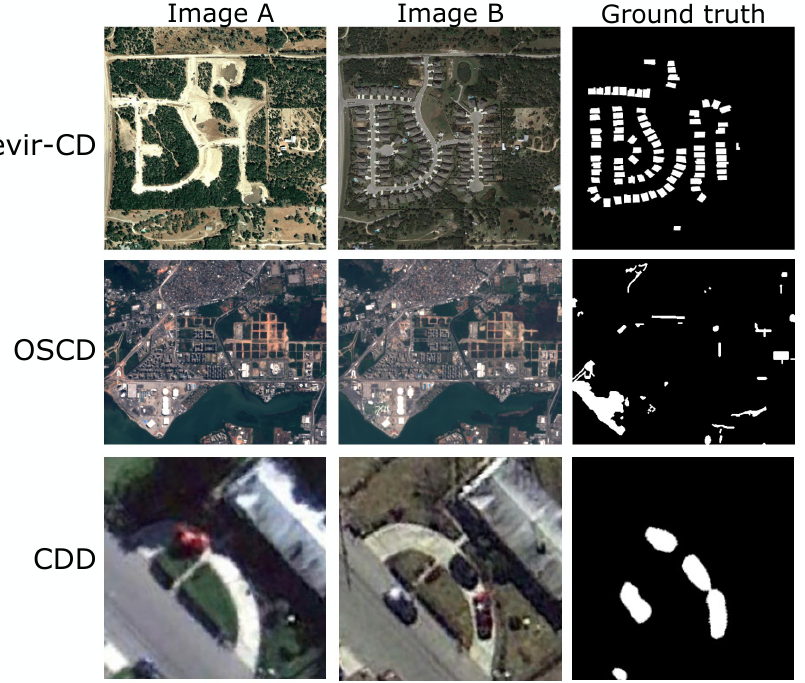
Figure 1. Examples of images and ground truth from various datasets, namely, Levir-CD [43] (with a focus on building changes), OSCD [39] and CDD [40] (various changes to infrastructure